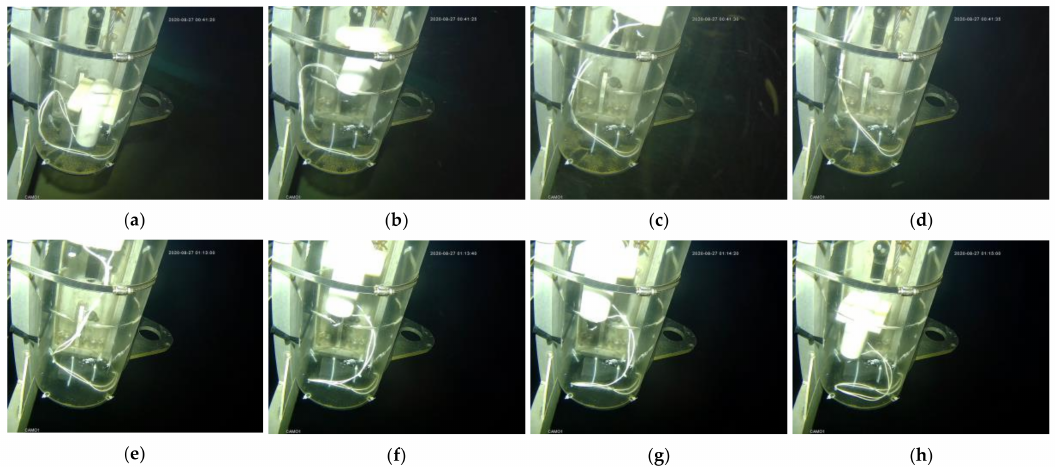
Figure 16. The phase-change BCM is capable of autonomous uplift and subsidence at a depth of 3223 m in the South China sea: ( a – d ) rising process; ( e – h ) descent